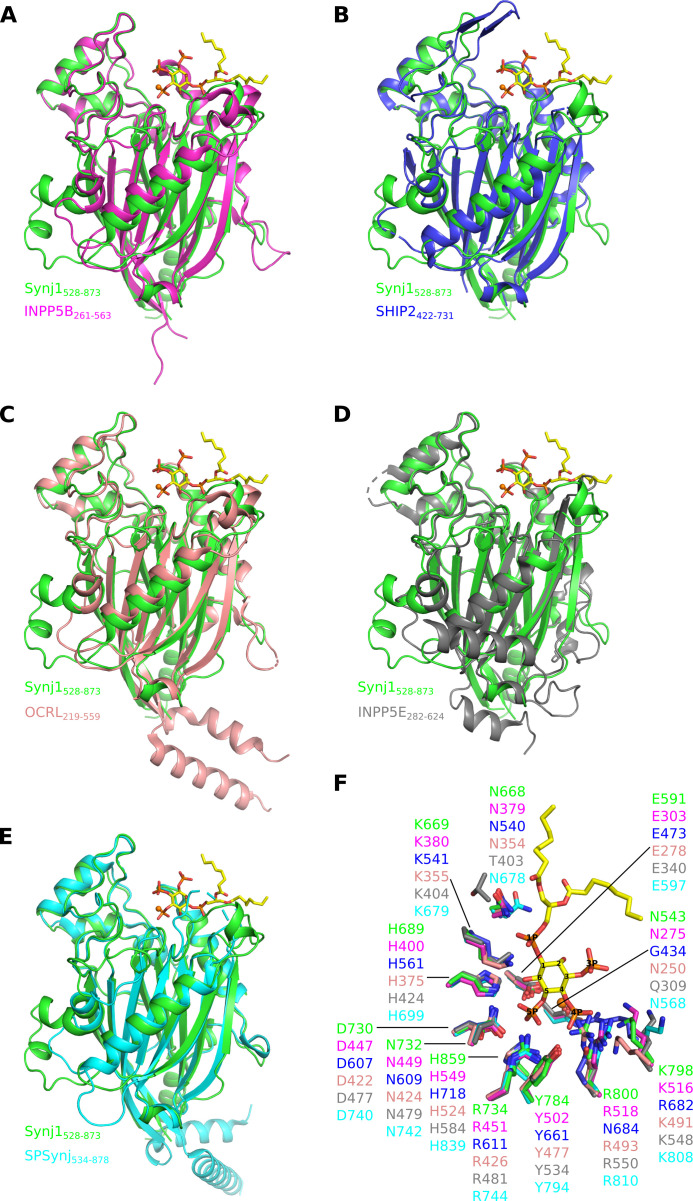
Superposition of the catalytic (5PPase) domain of human Synj1528–873 on the available structures of the other human 5-phosphatases and SPSynj.Superposition of Synj1528–873 (green, PDB 7A17) on the 5PPase domain of (A) INPP5B (magenta, PDB 4CML), (B) SHIP2 (blue, PDB 4A9C), (C) OCRL (salmon, PDB 4CMN), (D) INPP5E (grey, PDB 2XSW) and (E) SPSynj (cyan, PDB 1I9Z). The Mg2+-ion and the diC8-PI(3,4,5)P3 substrate of the Synj1528–873 structure are shown as an orange sphere and yellow sticks, respectively. (F) Zoom-in on the active site of the superposed 5PPases described in (A to E). For clarity, only the Mg2+-ion and the diC8-PI(3,4,5)P3 substrate of the Synj1528–873 structure are shown as an orange sphere and yellow sticks, respectively.